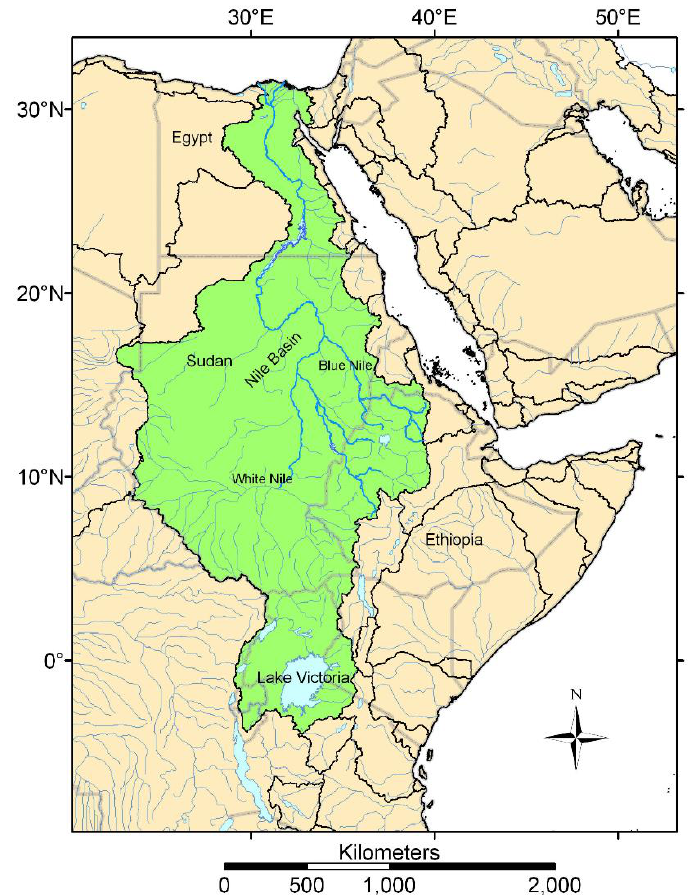
Figure 1. Map of the Nile Basin. The map indicates the two tributaries of the Nile: the Blue and White Nile. Source: Environmental Remote Sensing Laboratory (2018) [25].